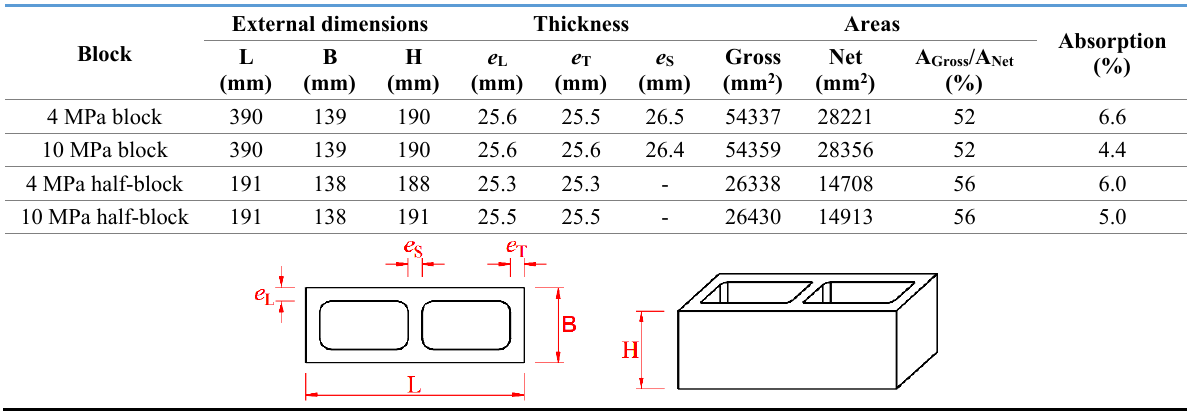
Table 2. Physical and geometric properties of blocks and half